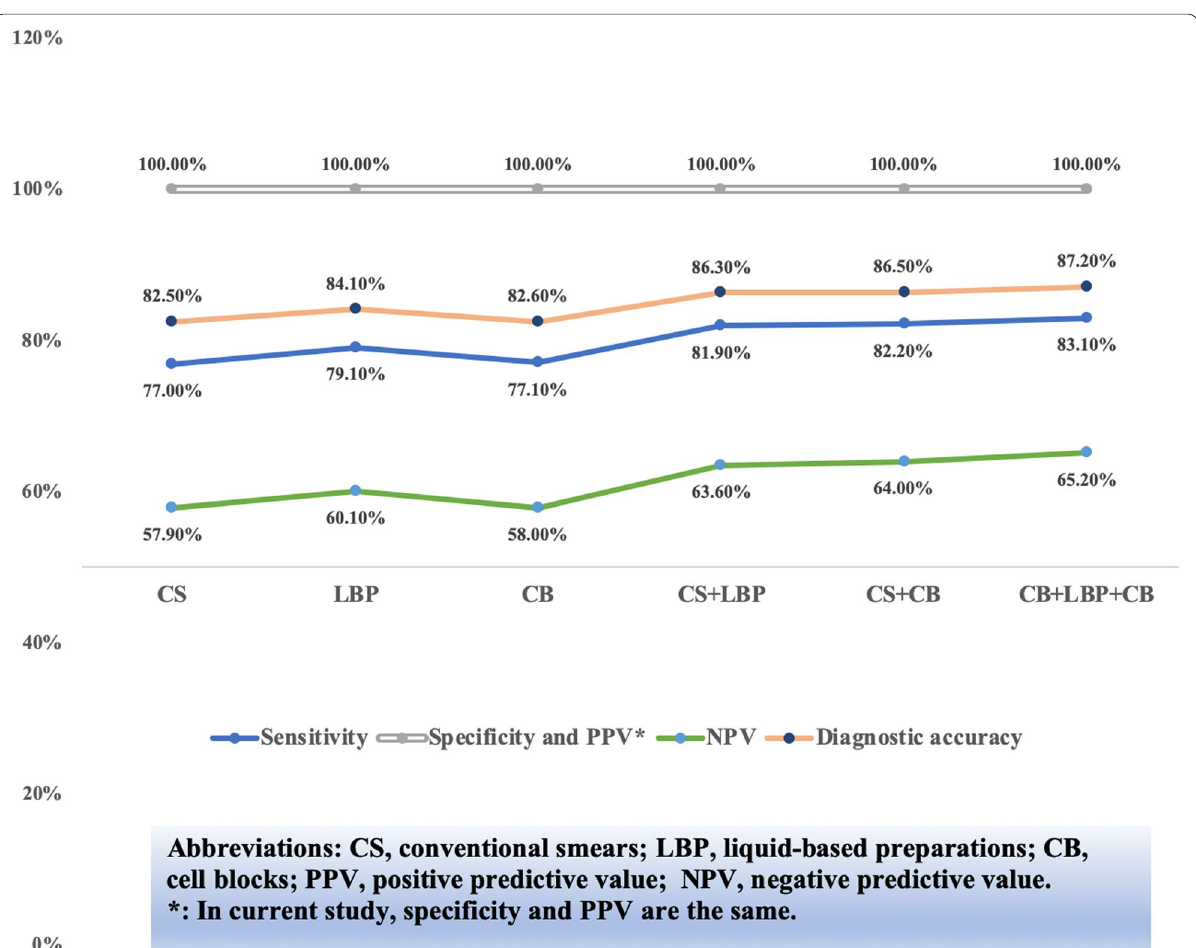
Fig. 4 The the performance evaluation among different sample preparations in 1288 cases when considering malignancy and suspicious of malignancy as